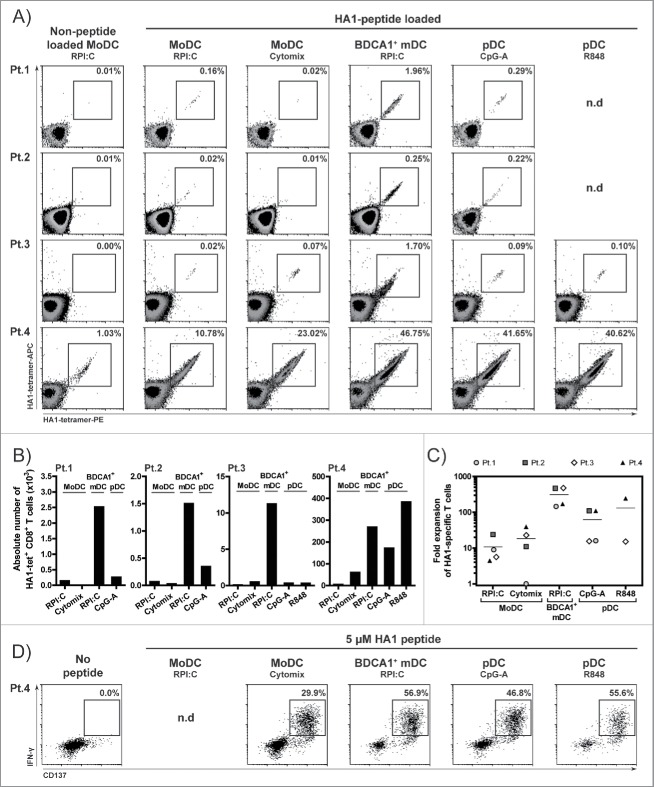
HSPC-derived BDCA1+ mDCs show superior capacity to expand and activate antigen-experienced CD8+ Tem cells. HSPC-DCs were generated as described in Fig. 1, and subsequently BDCA1+ mDCs were sorted from G4 culture and pDCs from FST culture. Next, the BDCA1+ mDCs, pDCs and autologous MoDCs were activated with respective TLR-ligands as indicated in the figure, in the presence of GM-CSF and IL-4 (MoDCs and BDCA1+ mDCs) or IL-3 (pDCs). Thereafter, TLR-matured HA-1 peptide-loaded DCs were co-cultured for one week with patient PBMCs at a 1:0.1 ratio (PBMC:DC) (n = 4). The HSPC-DCs and MoDCs used for expansion of patient HA1-specific CD8+ T cells were from unrelated third party donor apheresis products, as there was no apheresis material available of the corresponding transplant donors. The frequency of HA1-specific CD8+ T cells at day 0 was <0.02% in Pt. 1–3 and 0.61% in Pt. 4. (A) Density plots showing the percentage of HA1-specific CD8+ T cells at day 7. The numbers in the dot plots depict the percentage of positive cells within CD3+CD8+ T cells. (B) Absolute HA1-specific CD8+ T cell numbers after one week co-culture with DCs. (C) Fold expansion of HA1-specific CD8+ T cells, calculated by dividing the number of HA1-specific T cells at day 7 with the number of HA1-specific T cells at day 0. (D) 7-d DC-stimulated PBMCs of Pt. 4 were rechallenged overnight with 5 µM HA1-peptide and subsequently stained intracellular for CD137 and IFN-γ. As control, a small portion of cultured cells from all conditions was pooled and cultured overnight without HA1-peptide (No peptide). Numbers in the dot plots indicate the percentage of IFN-γ+ CD8+ T cells within CD3+CD8+ T cells. Pt. = patient. N.d. = not determined.